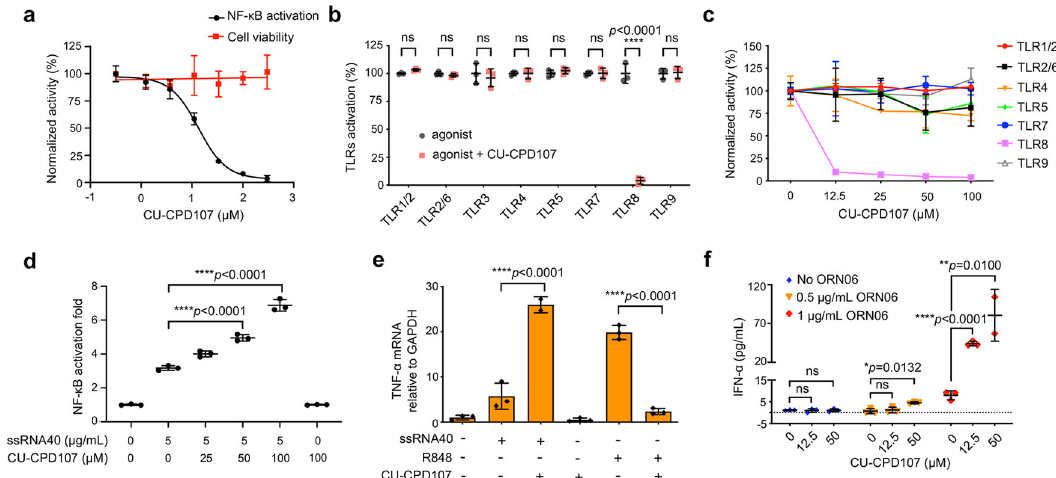
Fig. 3 Dichotomous behavior of CU-CPD107 in modulating the TLR8 signaling pathway. a The dose – response inhibition curve of 2.9 µ M R848-induced signaling in HEK-Blue hTLR8 cells is shown. Inhibition is clearly observed in HEK-Blue hTLR8 cells (IC 50 = 13.7 ± 1.1 µ M) with no obvious toxicity up to 300 μ M. Data are mean ± s.d.; n = 3 independent experiments. b Speci fi city test for CU-CPD107 (100 µ M) using TLR-speci fi c ligands to selectively activate the respective TLRs in HEK-Blue hTLRs cells for 24 h. Data are mean ± s.d.; n = 3 independent experiments. c Speci fi city test of CU-CPD107 in PBMCs.